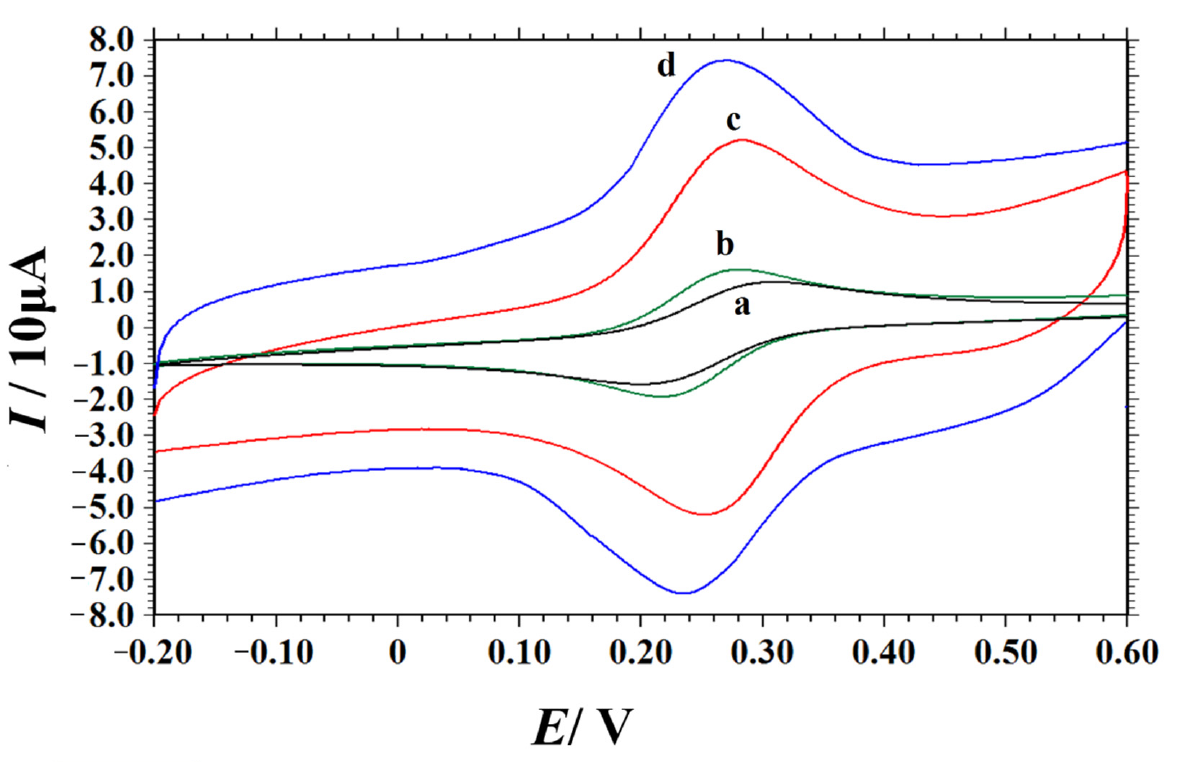
Figure 3. Cyclic voltammograms of 1.0 mM K 3 [Fe(CN) 6 ] in 0.5 M KCl solution obtained at bare GCE (a), PEI/GCE (b), NC/GCE (c) and NC–PEI/GCE (d). Scan rate: 0.1 V s − 1 .